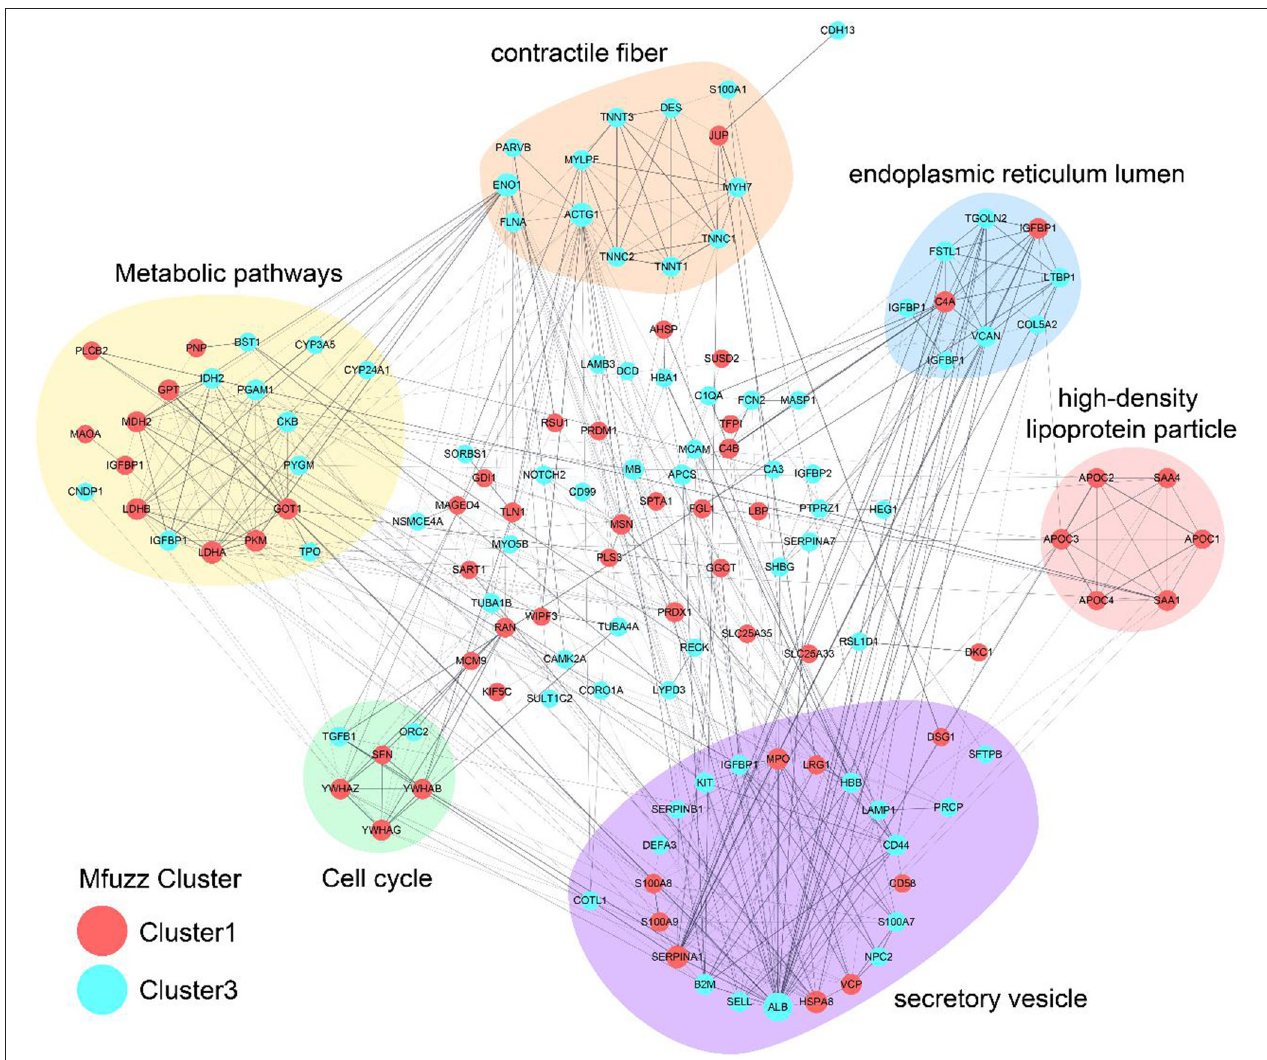
FIGURE 2 | Protein protein interaction network analysis. The lines are interactions, with the proteins in the red circle belonging to Cluster1 and the proteins in the blue circle belonging to